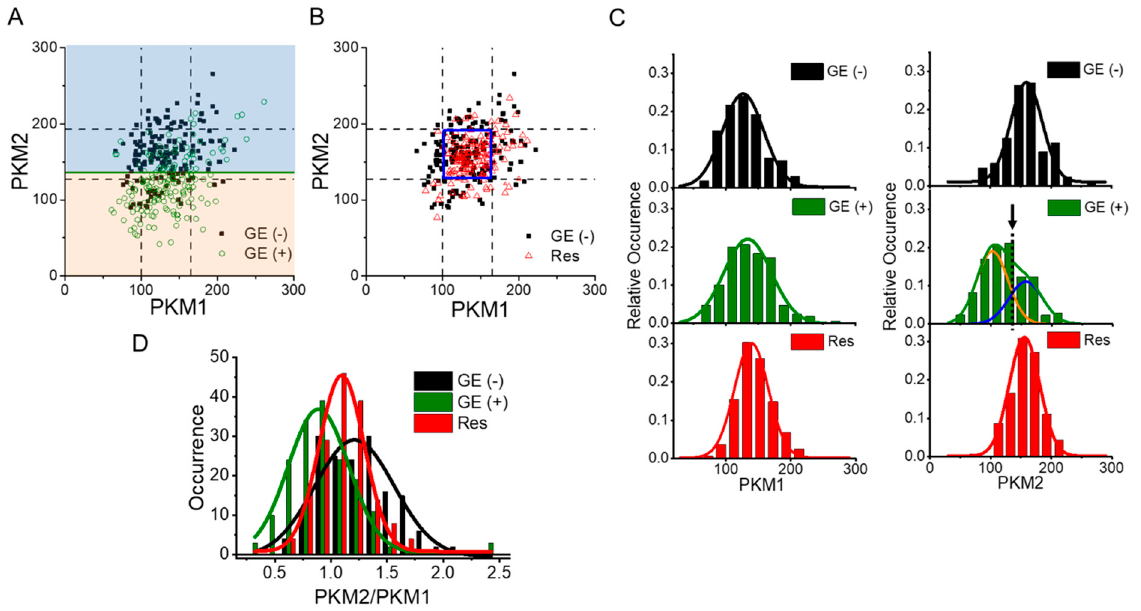
Figure 4. Effects of GE on the distribution of PKM isoforms. Cells were untreated (GE ( − )) or GE-treated for 24 h (GE (+)). GE-resistant cells (GE Res) were also analyzed. ( A ) 2D plot of each PKM isoform in GE ( − ) or GE (+). Each point corresponds to the number of mRNA molecules of each PKM isoform in individual cells. The dotted lines represent the average value ± SD of each PKM isoform in GE ( − ). The dark green line represents the value at which the two PKM2 Gaussian fits (shown in orange and blue in Figure 4C) overlap. ( B ) 2D plot of each PKM isoform in GE ( − ) or GE Res. Each point corresponds to the number of mRNA molecules of each PKM isoform in individual cells. The dotted lines represent the average value ± SD of PKM isoforms from GE ( − ). ( C ) Distribution of PKM1 (left) and PKM2 mRNAs (right). The black, dark green, and red lines represent the Gaussian fit of each distribution. In the PKM2 mRNA distribution (right), the dark green line represents the sum of the two Gaussian fits (orange and blue lines) for GE (+). The black arrow highlights the overlap of the two Gaussian fits. ( D ) Distribution of the ratio of PKM2 to PKM1. The black, green, and red lines represent the Gaussian fits of each distribution.